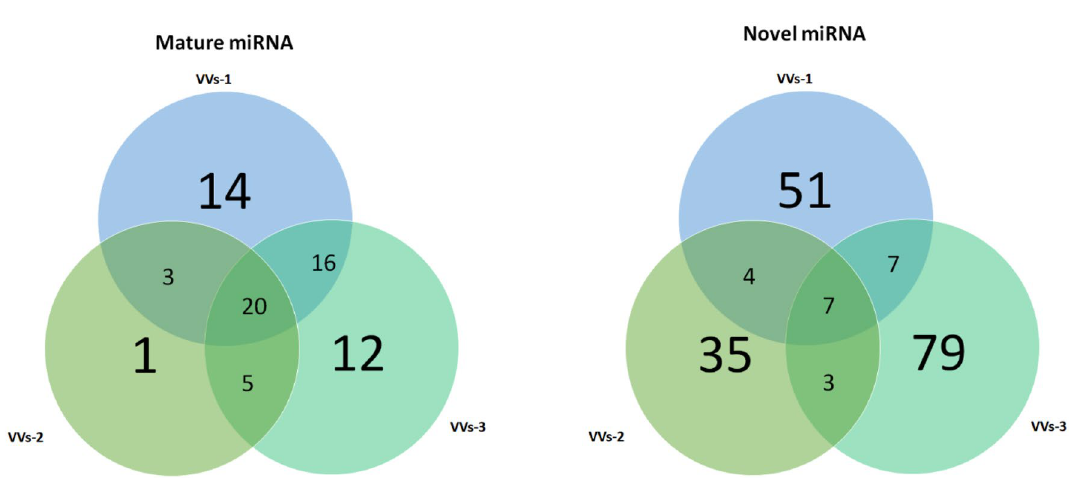
Figure 3. Venn diagram shows the numbers of matched mature and novel miRNAs in three samples of